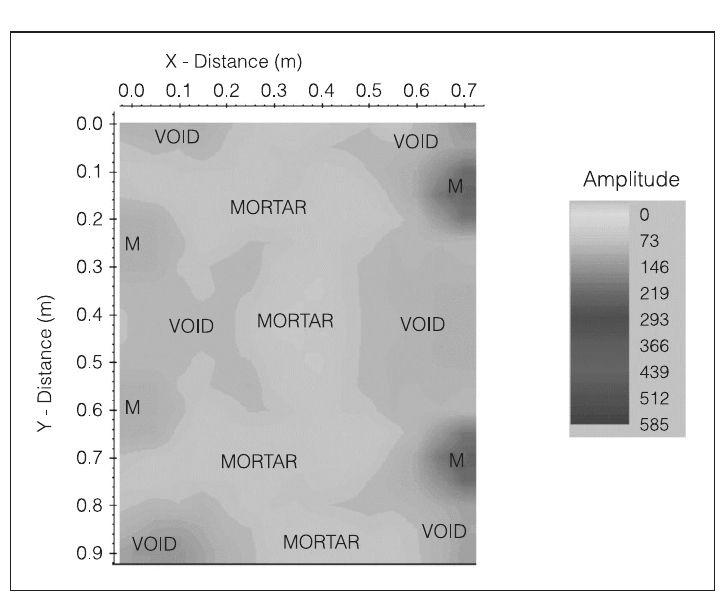
Fig. 8. Time slice for the 3.8 ns-5 ns time window with energy amplitude values. Note the presence of strong amplitude anomalies (labelled M ) that, because of the shape and the position, could be correlated to metal objects placed to fix the panel. The anomalies of weaker amplitude, in comparison with those suitable with M (labelled VOID), could be the